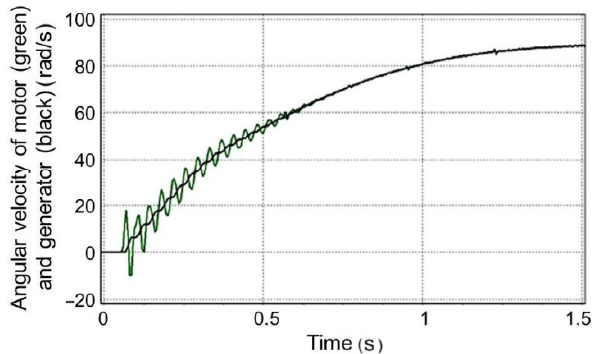
Figure 14. Measurement results of angular velocity of motor ω 1 and generator loading the drive system ω 2.